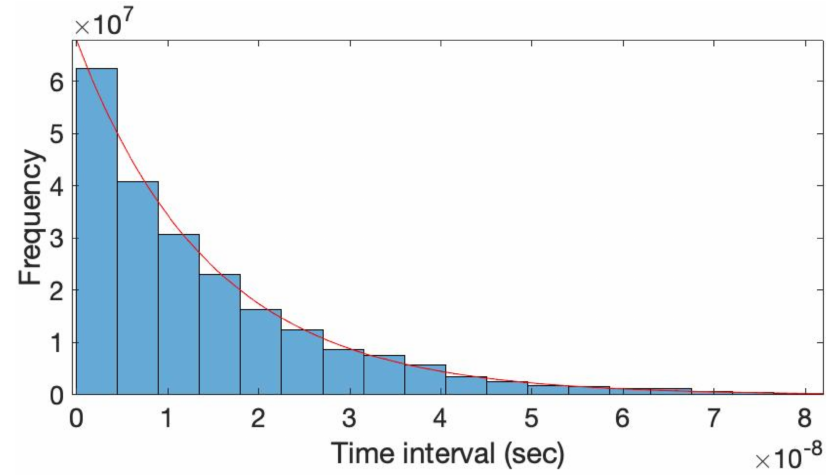
Figure 4. Time-interval histograms of the simulated output of Figure